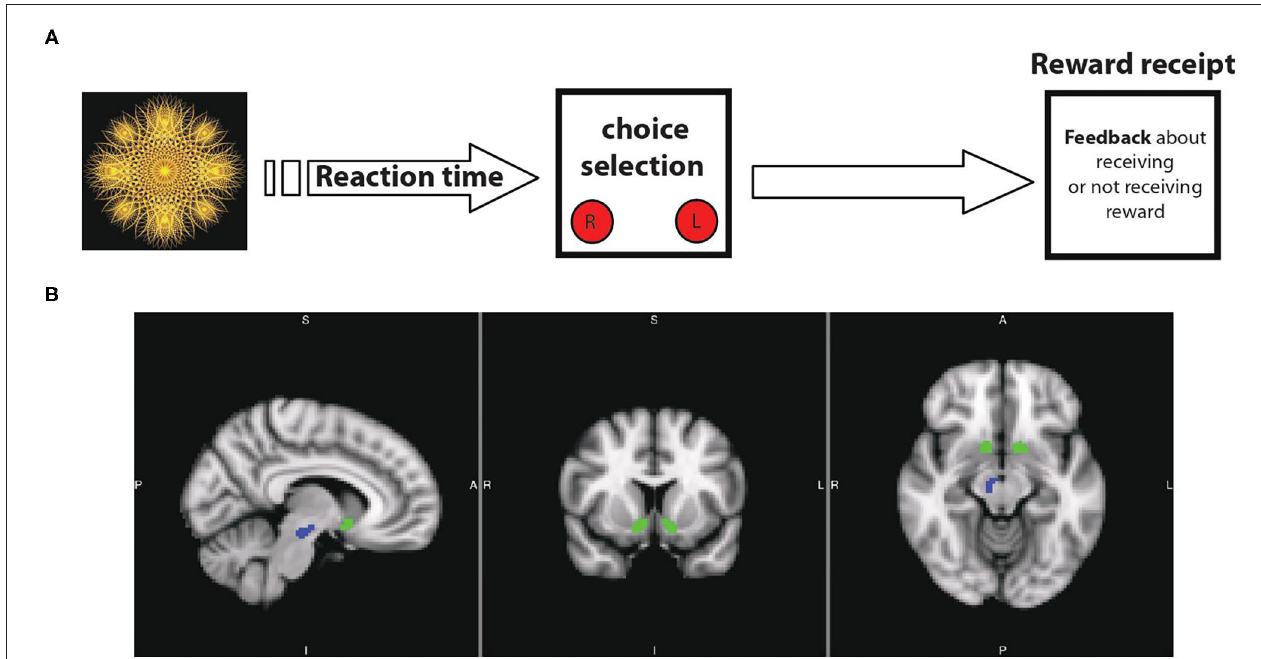
FIGURE 1 | (A) Schematic overview of task design: it includes sequential blocks with interval breaks between them. In the beginning of each block, presentation of a fractal image indicates the possibility of obtaining reward after pushing the right or left button. (B) Main nodes of mesolimbic circuit mediating motivational behaviors in human: ventral tegmental area \ substantia nigra pars compacta (VTA \ SNc, in blue) and nucleus accumbens (NAcc, in green).